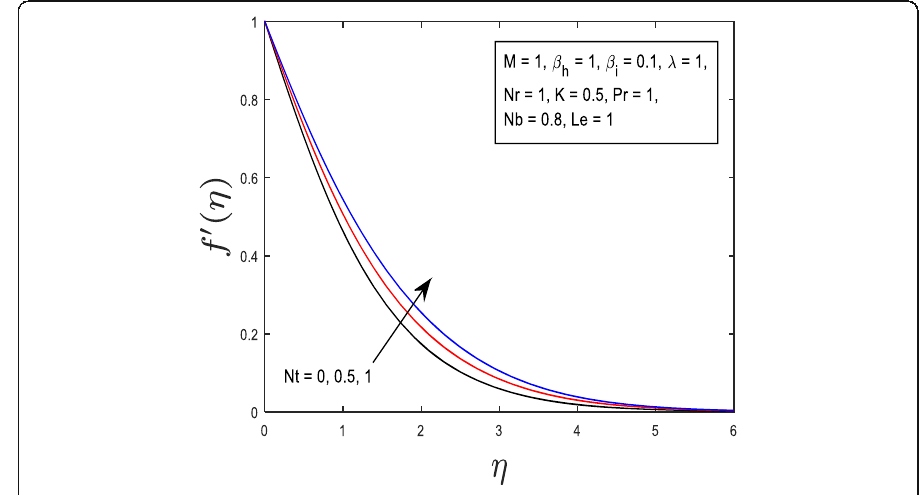
Fig 22 Graph of velocity for various values of